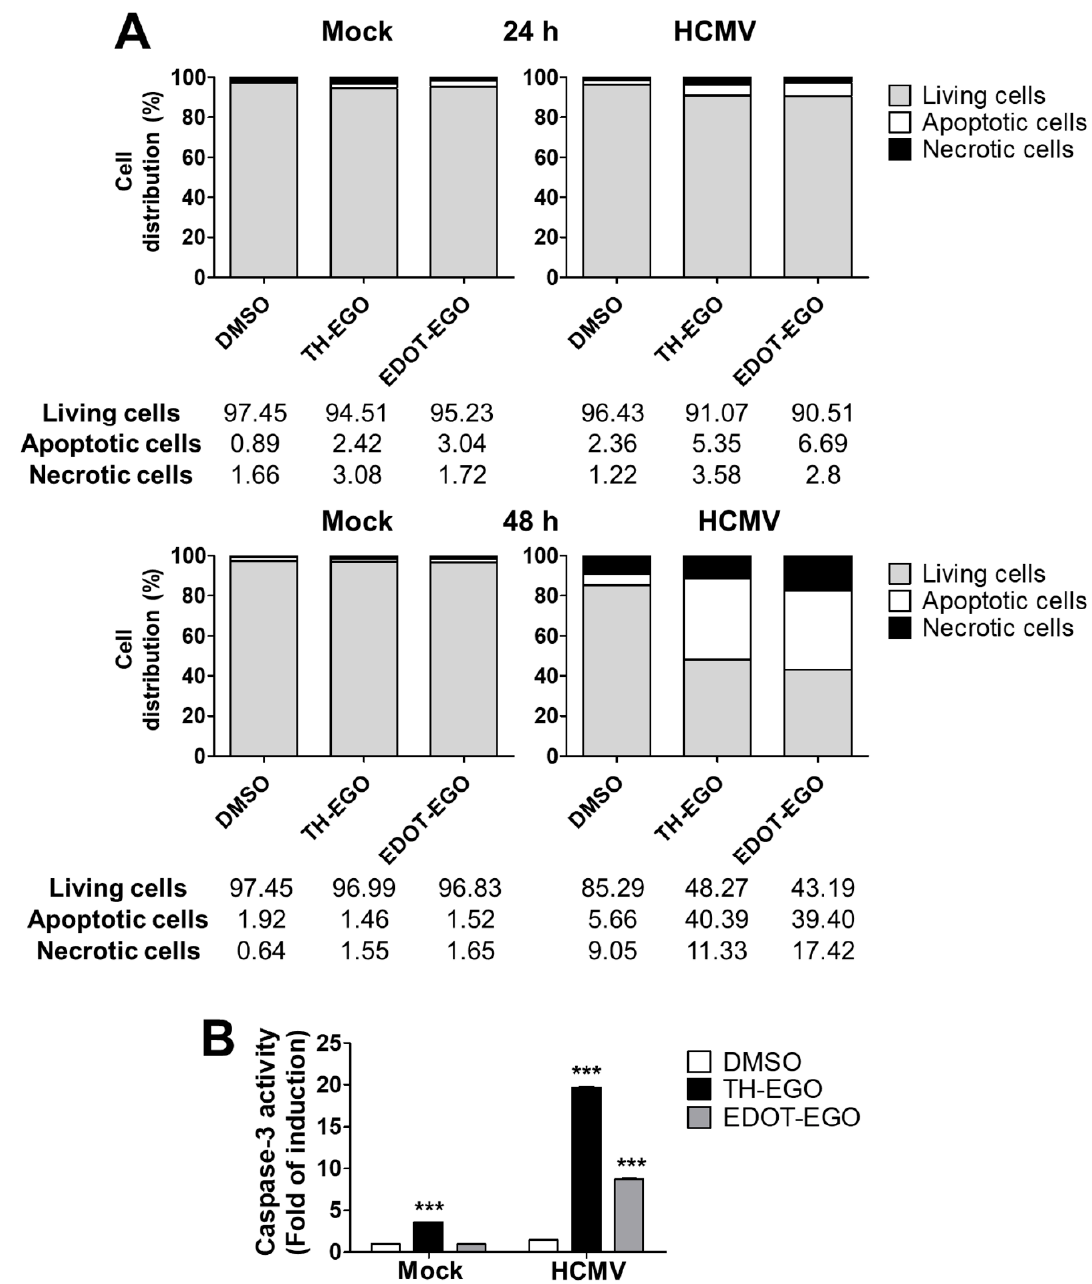
Figure 4. Interplay between apoptosis and SL analogs. ( A ) HFFs were treated with TH-EGO, EDOT-EGO (12.5 µM) or with equal volumes of DMSO solvent 1 h before infection and for the entire duration of the infection, and infected with HCMV (Merlin strain, MOI 1). After 24 h (upper panel) and 48 h (lower panel), cells were processed for Annexin V/propidium iodide (PI) flow cytometric analysis. Annexin-/PI- cells indicated living cells, Annexin+/PI- apoptotic cells and Annexin+/PI+ necrotic cells. Values were plotted as the percentage of cell distribution across the three different conditions. ( B ) HFFs were treated as described in ( A ) for 24 h with either SL TH-EGO, EDOT-EGO (12.5 µM) or with the solvent DMSO, in the absence or the presence of HCMV (Merlin strain, MOI 1) and processed via fluorimetric assay for caspase-3 activation. Fluorescence intensity is reported as RFU values (relative fluorescence units). Fold changes were calculated after the normalization of the SL-analogs vs. DMSO-treated cells, in mock or HCMV-infected cells. Data are shown as mean ± SD (***, p < 0.001, two-way ANOVA followed by Bonferroni’s post-tests).